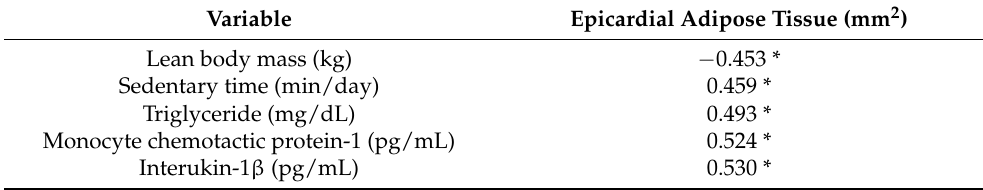
Table 5. Correlation coefficient between epicardial adipose tissue and cardiovascular risk factor ( n = 20). Variable Epicardial Adipose Tissue (mm 2 ) Lean body mass (kg) − 0.453 * Sedentary time (min/day) 0.459 * Triglyceride (mg/dL) 0.493 * Monocyte chemotactic protein-1 (pg/mL) 0.524 * Interukin-1 β (pg/mL) 0.530